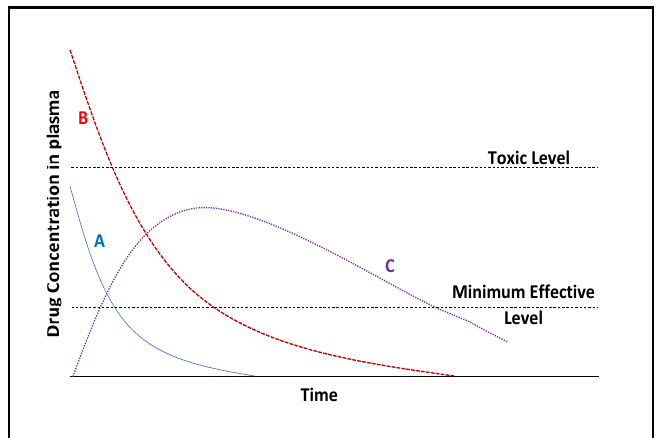
Figure 1. Drug serum concentration versus time for conventional dosage forms and an ideal slow- release dosage. Curve A (blue): Intravenous administration; B (red): intramuscular; C (purple): slow-release administration [adapted from 43]. A slow-release administration route allows for a drug serum concentration that is effective, non-toxic and sustained over a longer period in comparison to conventional administration routes.